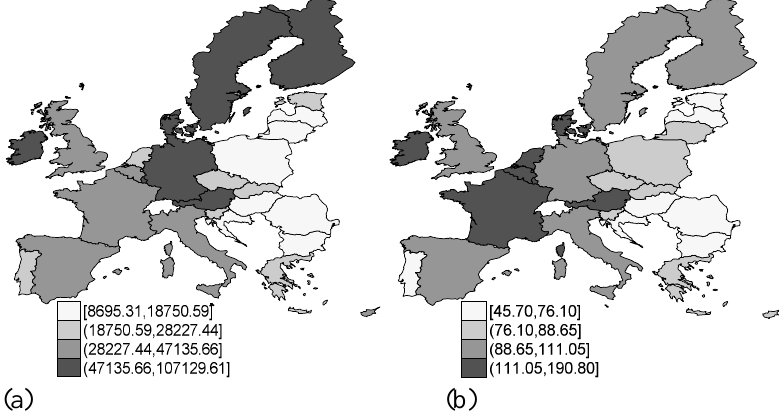
Figure 2. The economic development indicators, across EU – 28, 2018: